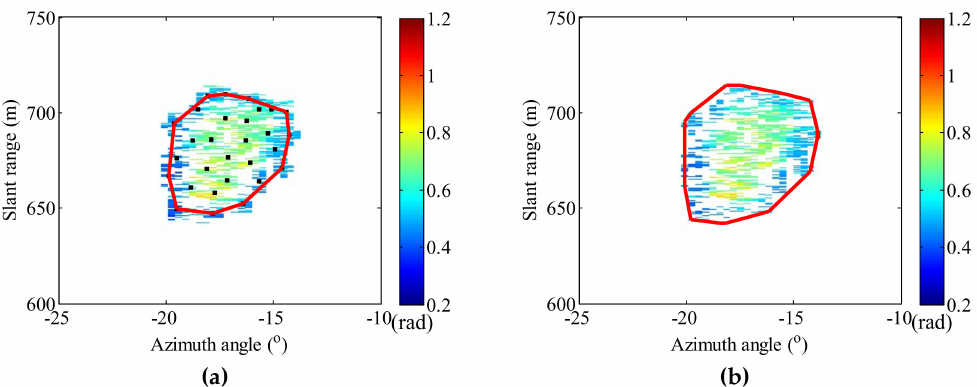
Figure 16. ( a ) Marginal cluster selection. ( b ) Selection result of the deformation-dominant PSs